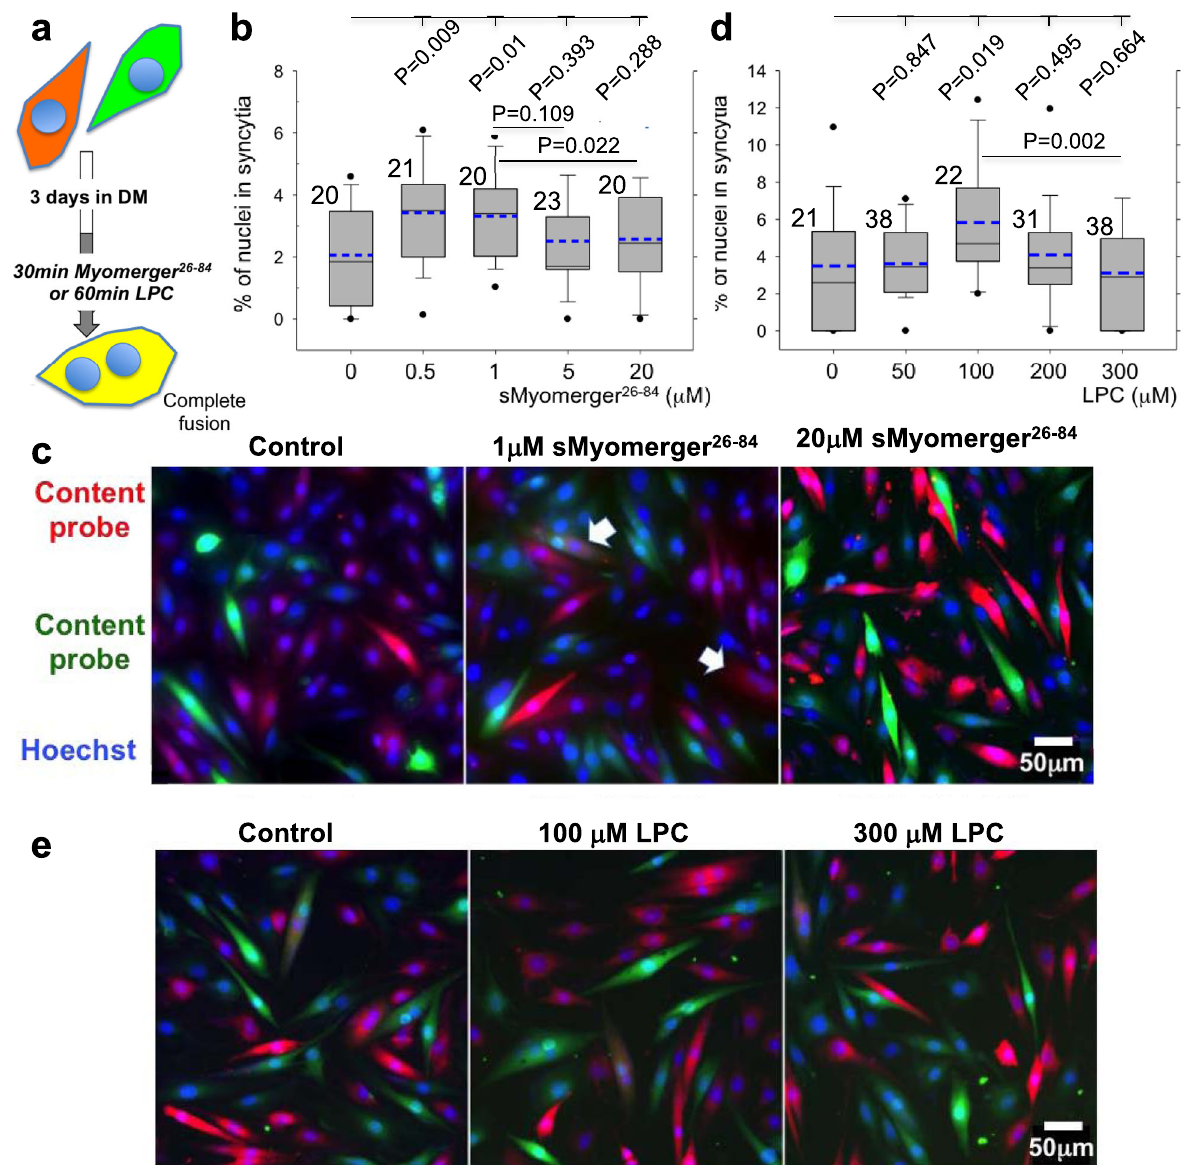
Fig. 6 A short-term application of sMyomerger 26-84 or LPC to Myomerger-de fi cient myoblasts promotes their complete fusion. a Schematic showing myoblast fusion assay. Myomerger-de fi cient C2C12 labeled with either orange cell tracker or green cell tracker were co-plated in the DM. Cell fusion was observed as formation of yellow (shown) or red or green multinucleated cells. After 3 days of the differentiation, we applied sMyomerger 26-84 for 30 min ( b , c ) or LPC for 60 min ( d , e ). Then we fi xed the cells and scored fusion as the ratio of nuclei in the cells with ≥ 2 nuclei to the total number of nuclei. b , d show the quanti fi cations of the fusion extents observed after application of sMyomerger 26-84 ( b ) or LPC ( d ). N , the number of randomly selected fi elds of view examined over three independent cell preparations for each condition, is indicated to the left of the box associated with that data. Box-and-whisker plots show median (center line), mean (blue line), 25 – 75th percentiles (box), 10 – 90th percentiles (whiskers), and 5 – 95th percentiles (solid circles). P - values were calculated using a two-tailed unpaired t -test. c , e Representative images for the experiments in b and d taken for the control cells and for the cells treated with 1 or 20 μ M sMyomerger 26-84 ( c ) or 100 or 300 μ M LPC ( e ). c , e Arrows mark examples of fusion. Scale bar 50 μ